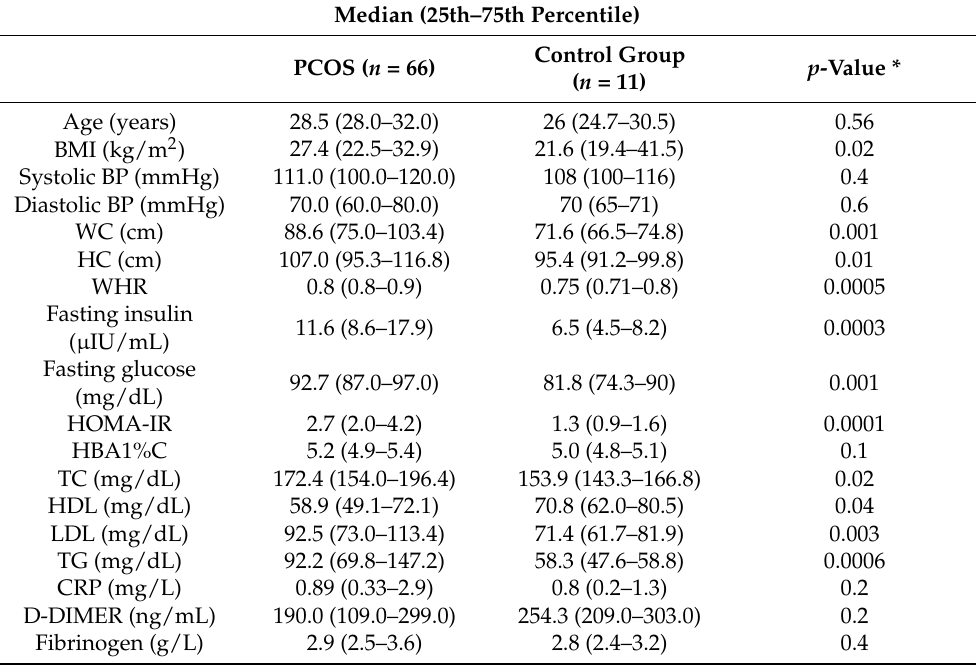
Table 1. Characteristic and comparison of whole PCOS group and controls.